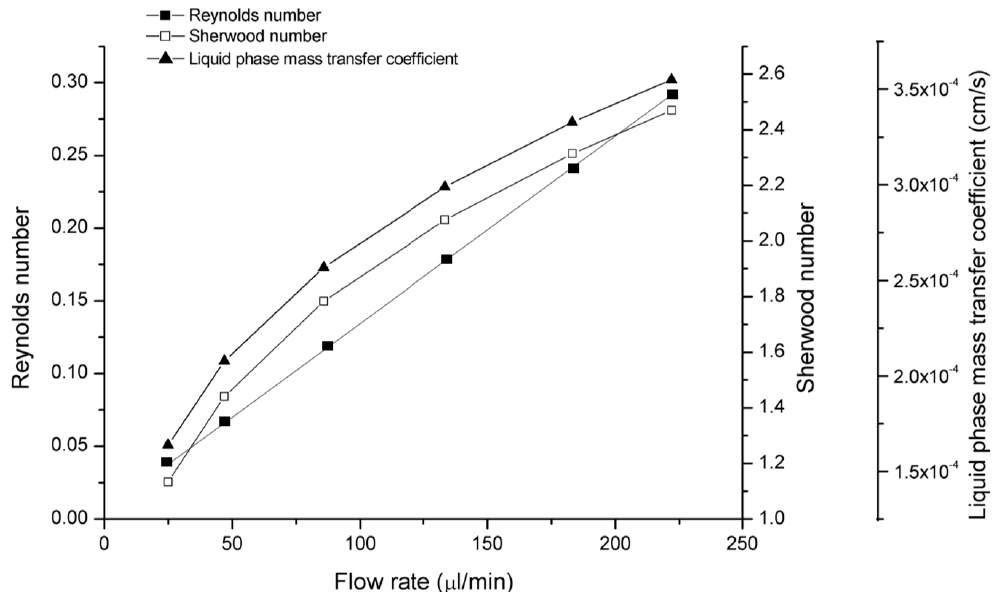
Figure 6. Determination of the Reynolds ( N Re ) and Sherwood ( N Sh ) number and corresponding liquid film mass transfer coefficient ( K L ) values for flow rates in the range of 20.8 to 219.0 µ L · min − 1